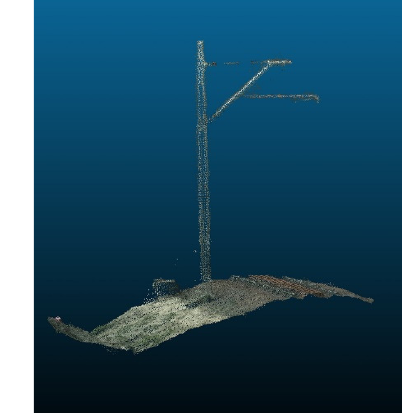
Figure 4. Examples of objects cut from a point Figure 4 . Examples of objects cut from a point cloud.